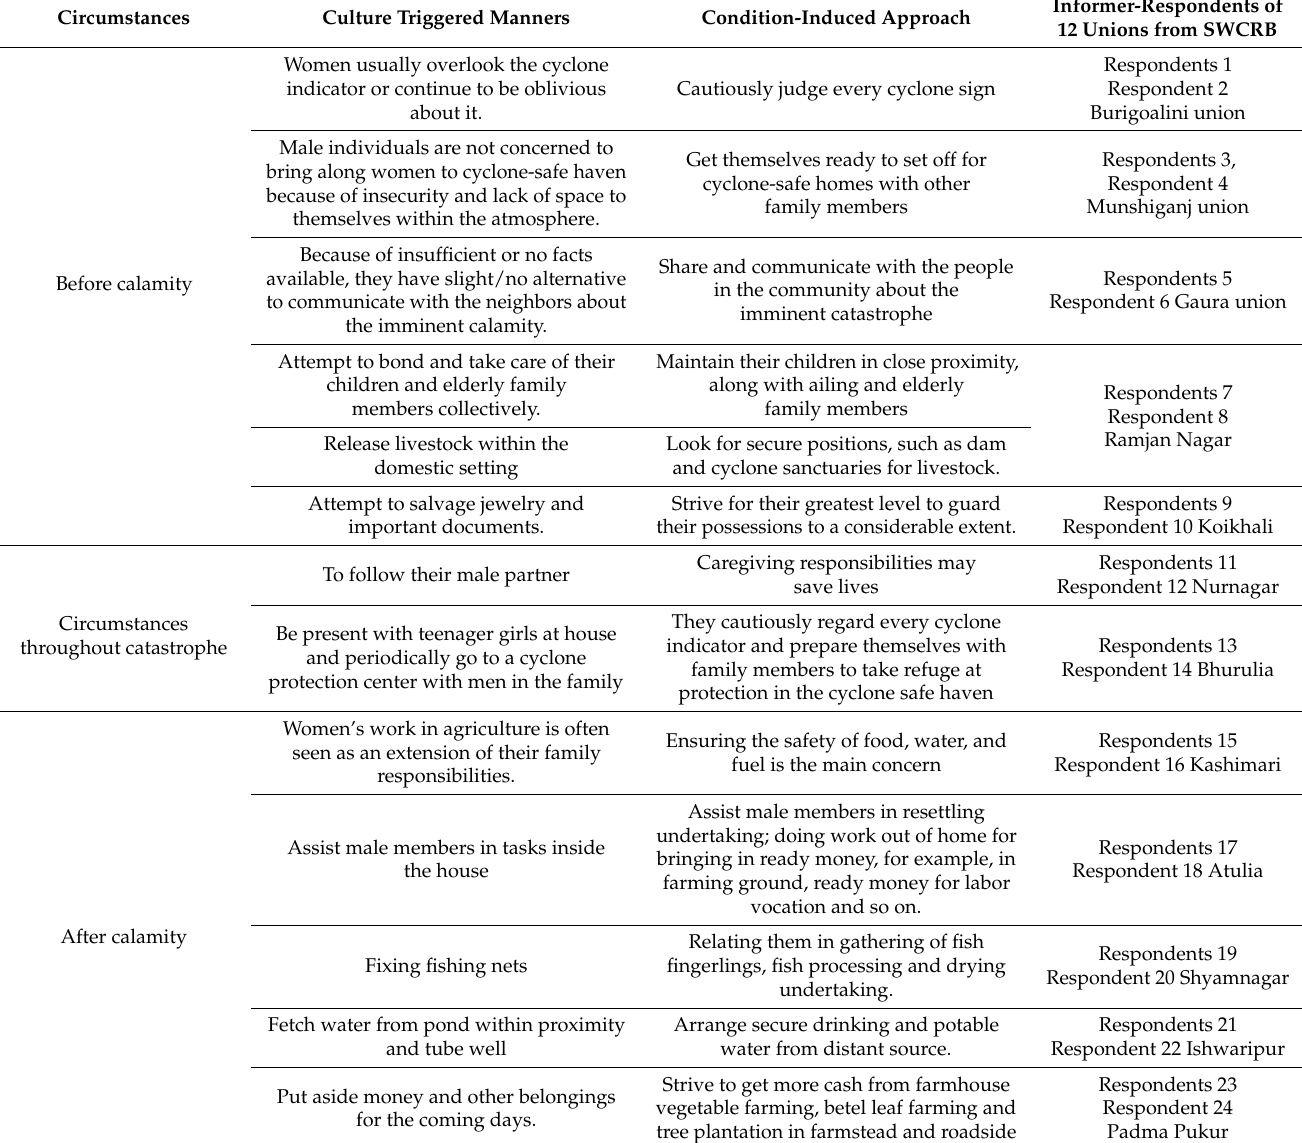
Table 6. Culture and condition induced tackling mechanism of women before, during, and after